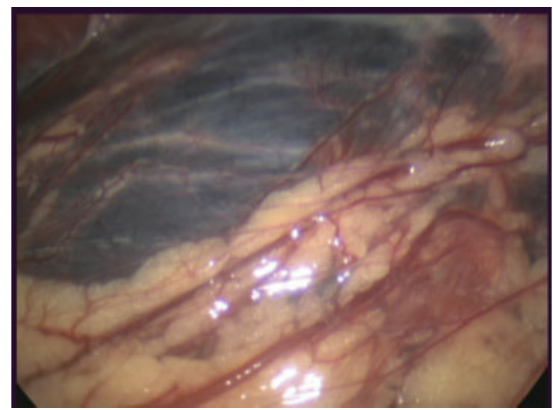
Fig. 1 Intraoperative image illustrating cyst location adherent to omental tissue.